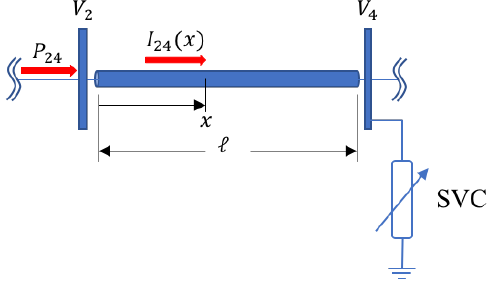
Figure 6. SVC-compensated transmission line